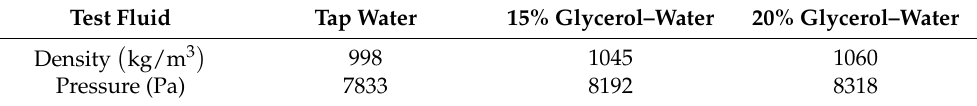
Table 2. Density and pressure values for the test fluids used in the permeability measurements.